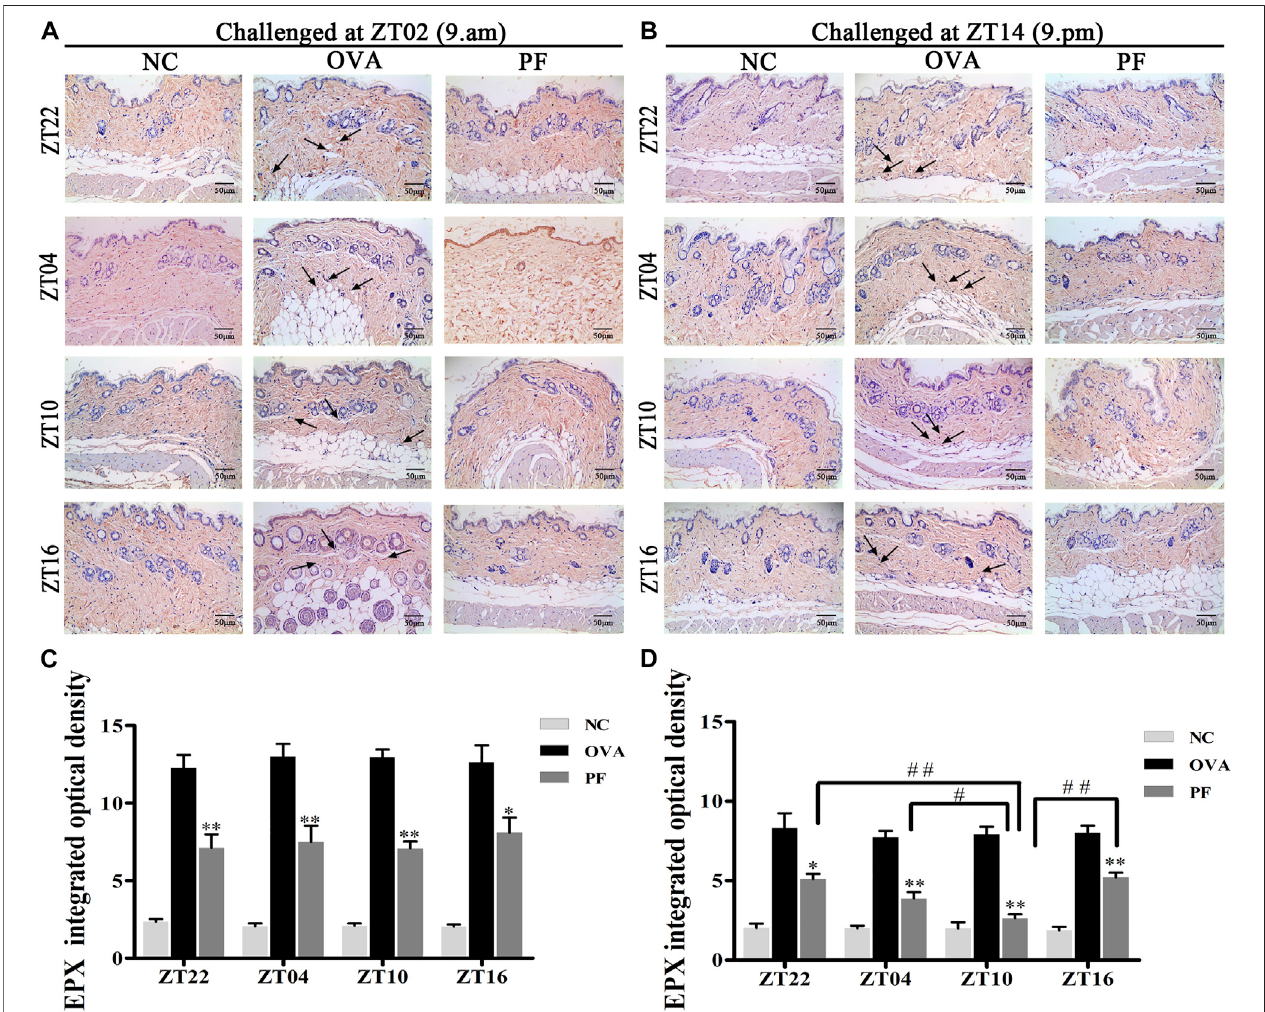
FIGURE 6 | Representative low-magni fi cation light photomicrographs (A,B) and integrated optical density (C,D) displaying immunohistochemistry of eosinophil proteinX(EPX)(blackarrows).ThePFtreatmentatZT10hadagreatereffectonEPXproduction.Dataareexpressedasmean±SEM( n =6).* p < 0.05,** p < 0.01versus OVA mice at the same time points. # p < 0.05, ## p < 0.01 represents the comparison of PF ZT10 versus the other three PF groups. The magni fi cation was ×200.